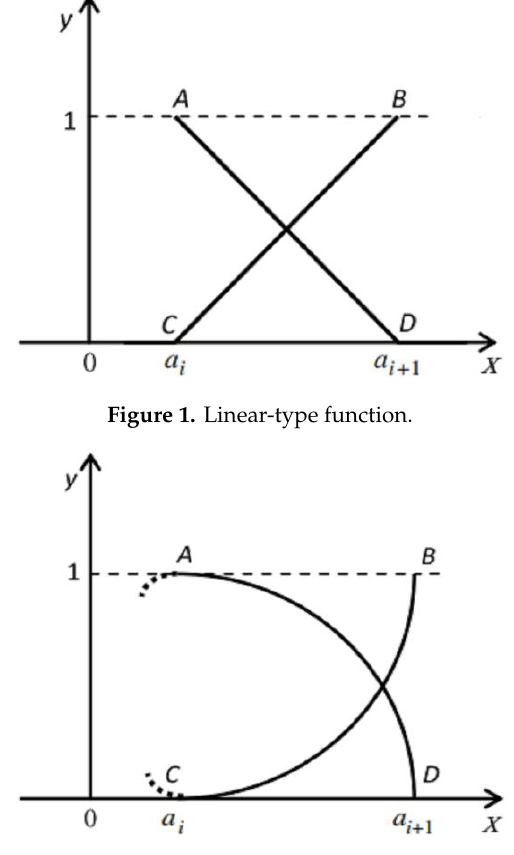
Figure 2. Parabolic-type function.